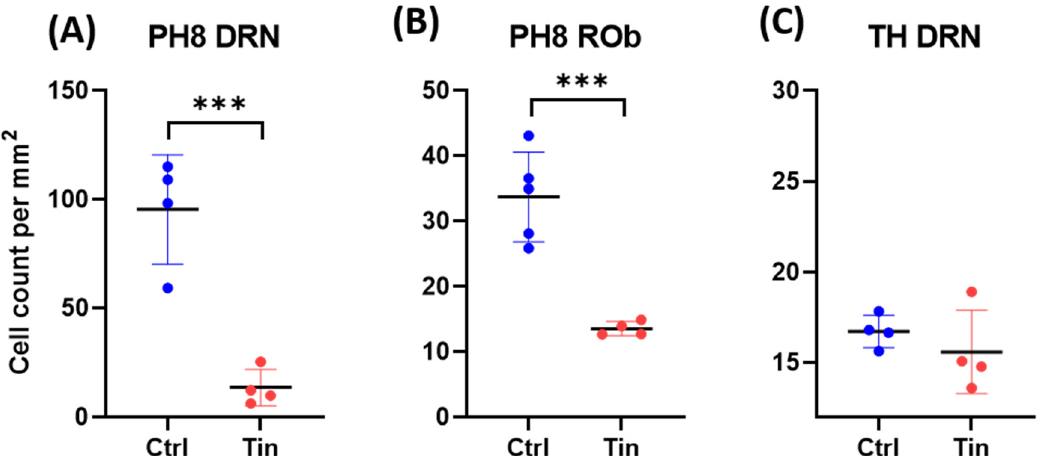
Figure 6. Cumulative data showing the means and standard error of means (SEMs) of PH8 ( A , B ) and TH ( C ) cell density in the DRN and ROb of tinnitus and control subjects. p value < 0.001 is indicated by a (***). Note the significant reduction in PH8 cell density in the DRN and Rob of tinnitus patients.